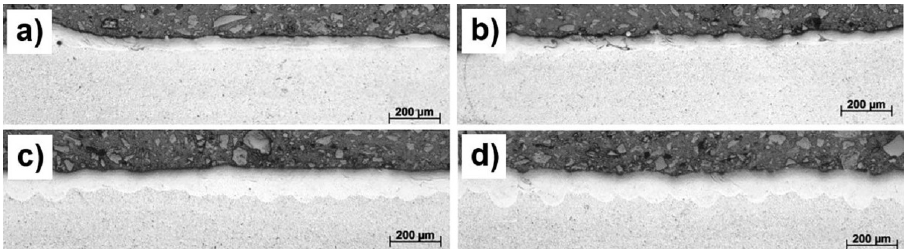
Figure 1. Cross ‐ sections of the surfaces of LPBF Ti6Al4V (ELI) ‐ 1 at % Cu manufactured at the laser Figure 1. Cross-sections of the surfaces of LPBF Ti6Al4V (ELI)-1 at % Cu manufactured at the laser power of 170 W, scanning speed 1.0 m/s: ( a ) 70 μ m hatch distance, single scan strategy; ( b ) 70 μ m power of 170 W, scanning speed 1.0 m/s: ( a ) 70 µ m hatch distance, single scan strategy; ( b ) 70 µ m hatch distance, rescan strategy; ( c ) 100 µ m hatch distance, single scan strategy; ( d ) 100 µ m hatch distance, rescan